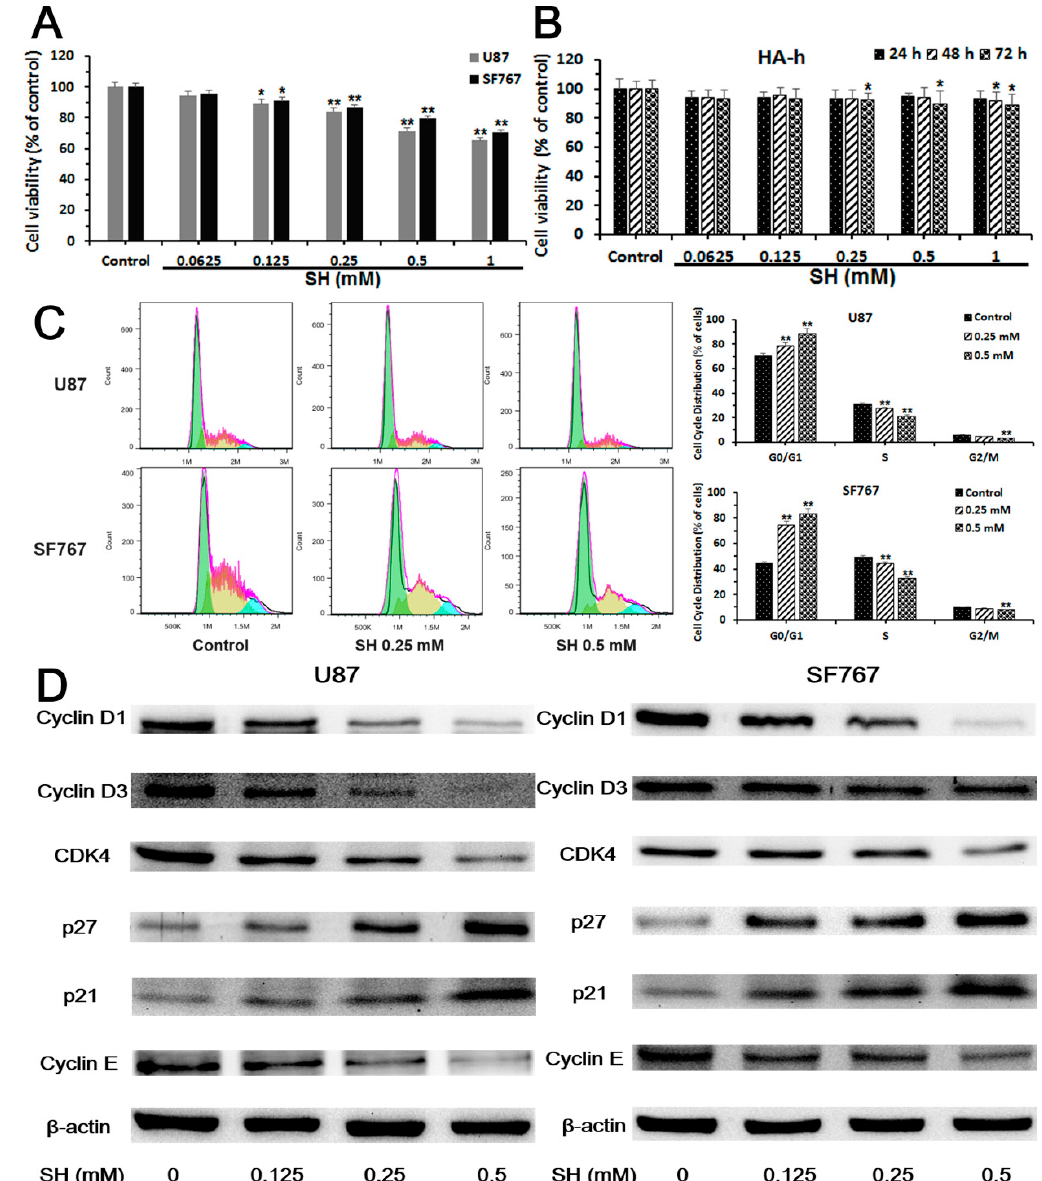
Figure 1. Sinomenine hydrochloride (SH) selectively kills human glioblastoma cells, but not normal glial cells, and induces human glioblastoma cell cycle arrest. ( A ) The human glioblastoma cell lines were treated with SH (0.0625 to 1.0 mM) for 24 h, and cell counting kit-8 (CCK-8) assays were applied to analyze cell viability; ( B ) HA-h cells were treated with SH (0.0625 to 1.0 mM) for the indicated time points, and CCK-8 assays were used to examine cell viability; ( C ) Analysis of the DNA content and histograms of the cell cycle phase distribution of U87 and SF767 cells treated with SH (0.25, 0.5 mM) for 24 h; ( D ) The indicated concentrations of SH dose-dependently altered the levels of cell cycle-related proteins in U87 and SF767 cells at 24 h. Each blot and image shown is representative of n = 3 experiments. All data are presented as means ± SEM, n = 3. * p < 0.05, ** p < 0.01 compared with the control.